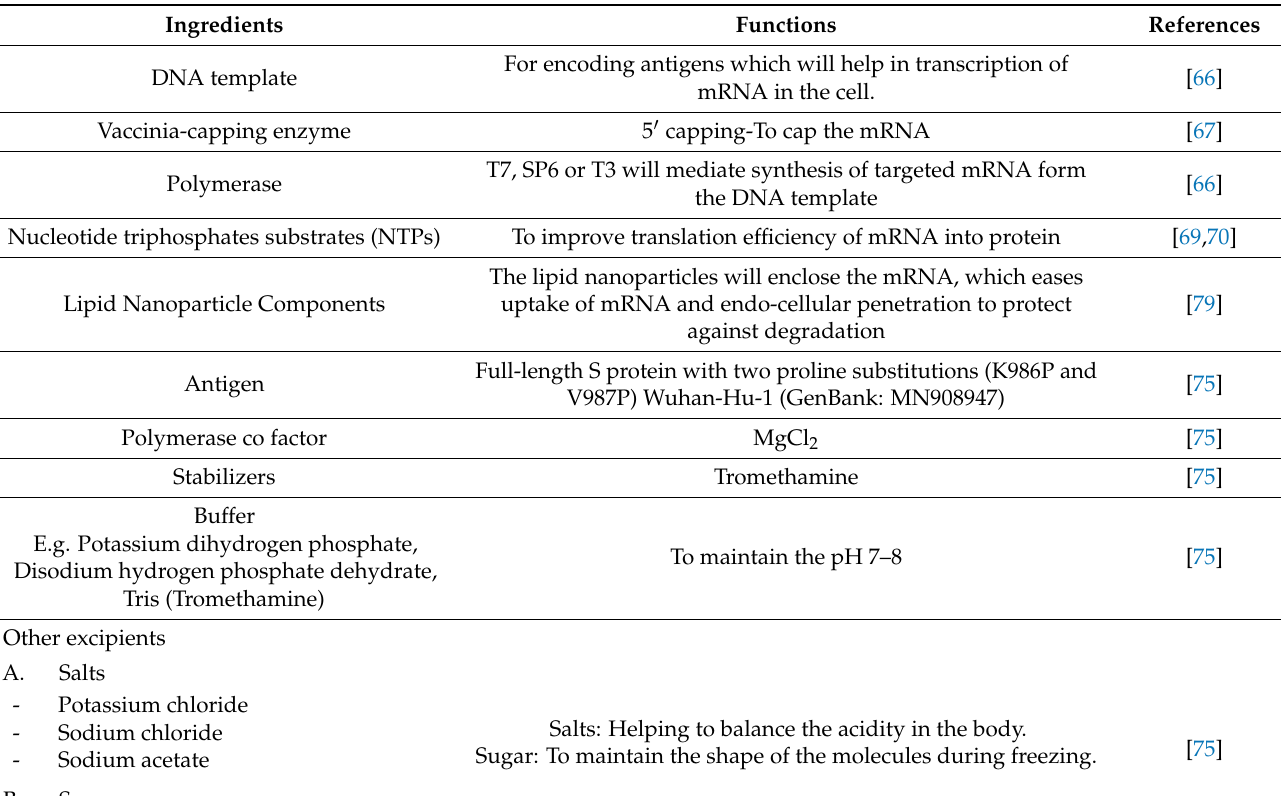
Table 2. Key ingredients used in mRNA-based vaccines.